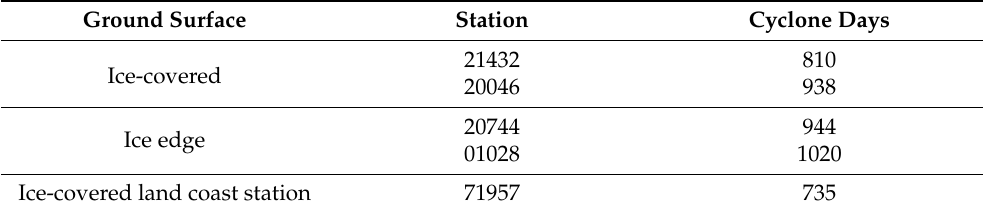
Table 1. Number of cyclone days at the five selected stations during autumn in the period